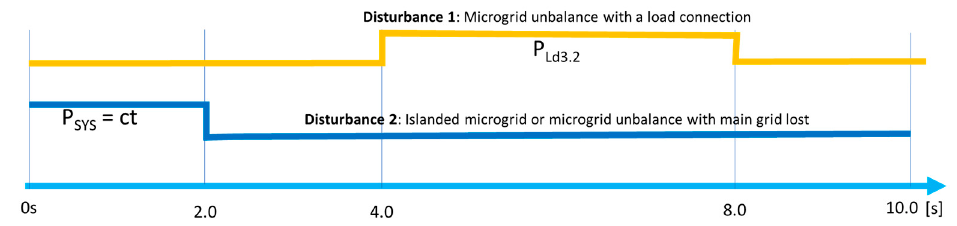
Figure 7. Timeline for Scenario 3: longer term disturbances with a simplified microgrid.